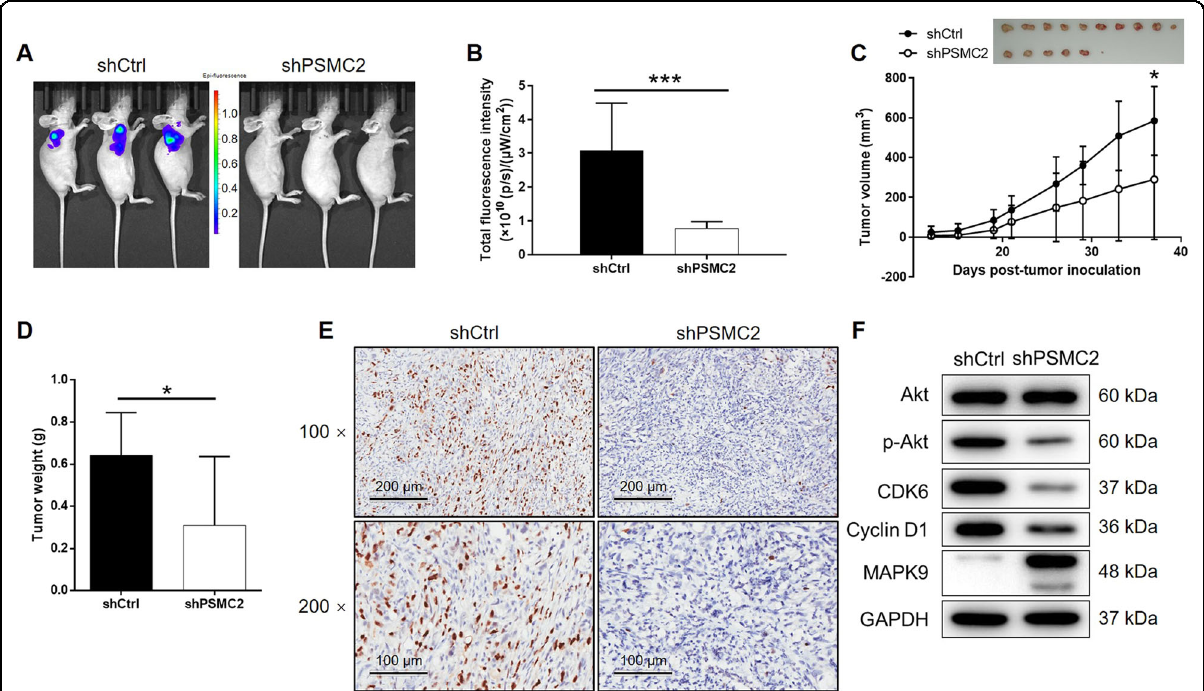
Fig. 5 PSMC2 knockdown inhibited GBC development in vivo. A In vivo imaging was performed to evaluate the tumor burden in mice of shPSMC2 and shCtrl groups at day 37 post-tumor-inoculation. B The fl uorescence intensity was scanned and used as a representation of tumor burden in mice of shPSMC2 and shCtrl groups. C 12 days post-injection of GBC-SD cells with or without PSMC2 knockdown, the volume of tumors formed in mice was measured and calculated at indicated time intervals. D Mice were sacri fi ced at day 37 post-injection, and the tumors were removed for collecting photos (inset of C ) and weighing. E After removing the tumors, the Ki67 index was evaluated by IHC staining as a representative of tumor growth activity. F The expression of Akt, p-Akt, CDK6, Cyclin D1, and MAPK9 was detected by western blotting in GBC-SD cells with or without PSMC2 knockdown. Data were shown as mean ± SD. * P < 0.05, *** P <